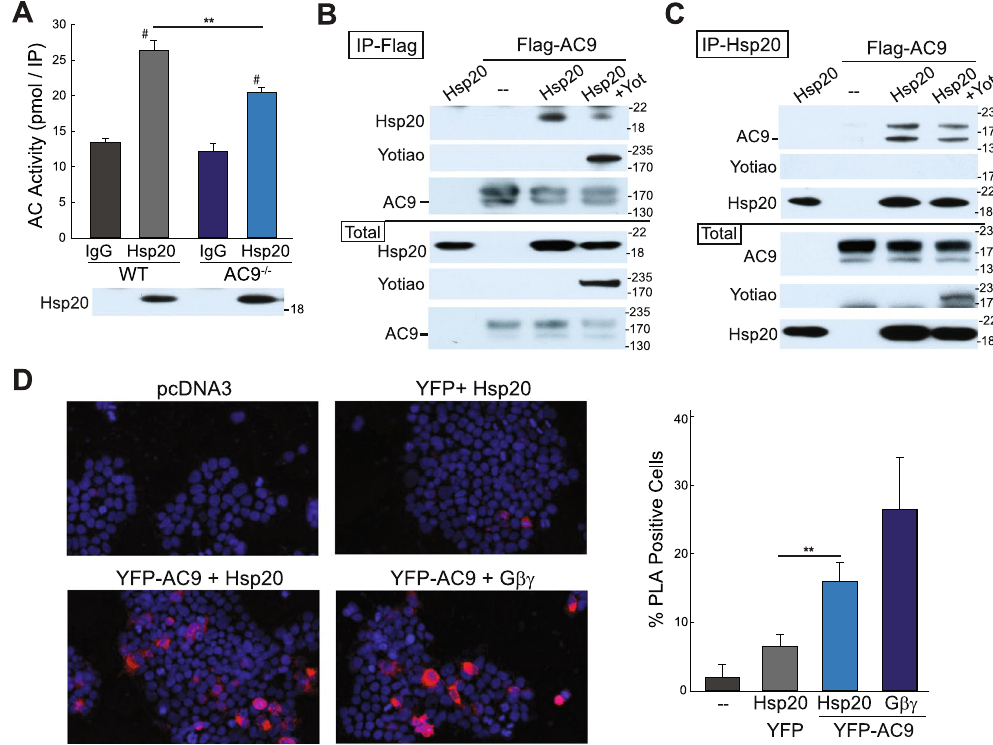
Figure 4. AC9 association with Hsp20 is Yotiao independent. ( A ) Heart extracts from WT or AC9 − / − mice were subjected to IP with IgG (control) or anti-Hsp20. Hsp20-associated AC activity was stimulated with 300 nM G α s (n = 4; # P < 0.001 IgG versus Hsp20; ** P < 0.01 WT versus AC9 − / − ). ( B , C ) HEK293 cells were transfected with Flag-tagged AC9, myc-tagged Yotiao, and V5-tagged Hsp20 as indicated. Cell lysates were immunoprecipitated with anti-Flag ( B ) or anti-Hsp20 (C ). AC9-Hsp20 protein complexes were detected by WB (n = 3). ( D ) Proximity ligation assay for Hsp20 and YFP-tagged AC9. HEK293 cells were transfected with the indicated plasmids. Representative images are shown. PLA signals were quantified by high content microscopy (positive cells defined as 4 signals or “dots” per cell; ~2000 cells imaged per condition). * P < 0.05 t-test, n = 3. Full-length WBs are presented in Supplementary Fig.